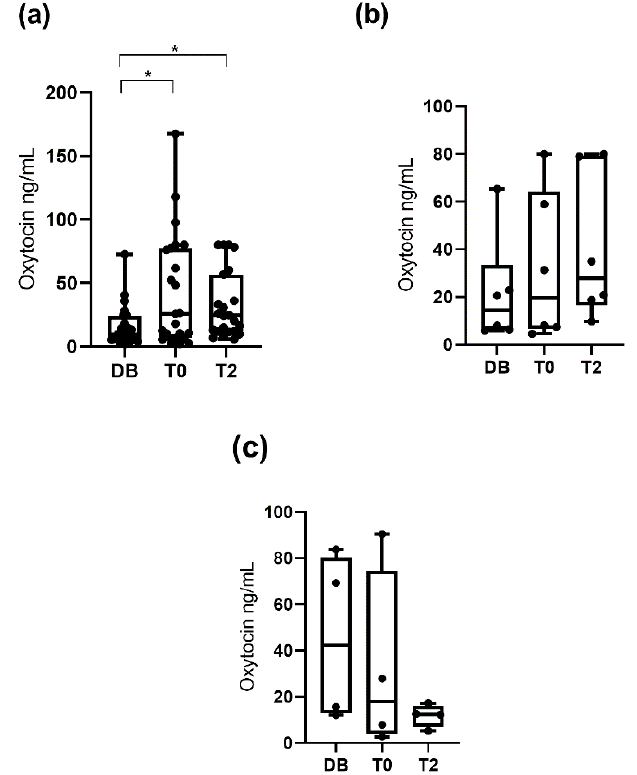
Figure 6. Changes in salivary oxytocin concentrations measured with AlphaLISA polyclonal method at different times: the day before ejaculate collection (DB), immediately after starting the ejaculation (T0) and two hours after ejaculation (T2). Figure ( a ) shows the data for boars with libido intensity of 3 and ( b ) and ( c ) those with libido intensity of 2 and 1, respectively. The plots show medians (line within box), 25th and 75th percentiles (boxes), min and max values (whiskers) and individual data points. Asterisk indicate differences between times (* p ≤ 0.05).